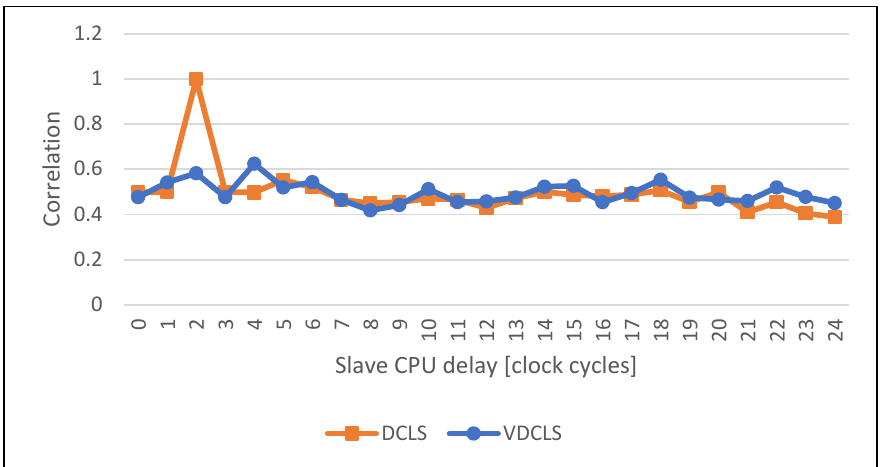
Figure 10. Comparison of the execution correlation between master and slave CPUs using VDCLS and legacy DCLS technique while executing the SHA algorithm.